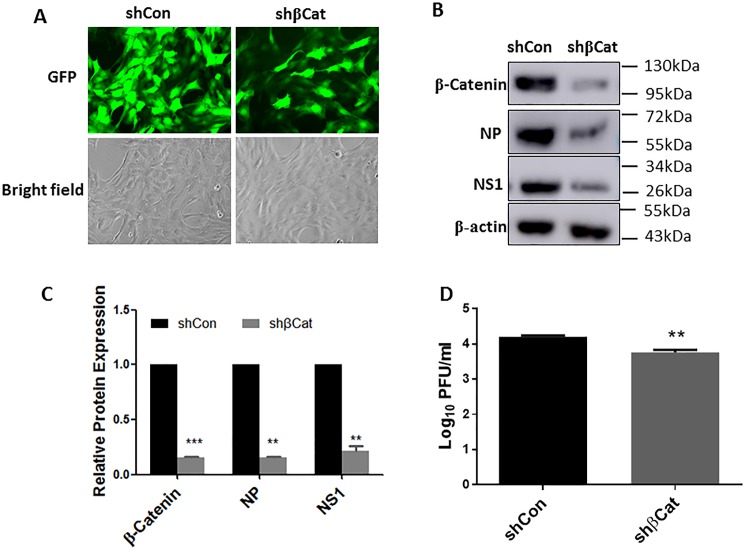
Knockdown of β-catenin reduced viral replication.Rat lung epihtelail L2 cells were treated with adenoviral shRNA targeting β-catenin (shβCat) or a control vector (shCon) at an MOI of 100 for 48 h and then infected with A/PR/8/34 (MOI 0.01) for 48 h. (A) GFP signal after 48 h adenoviral infection. (B) Representaive western blots of β-catenin and viral proteins, NS1 and NP. (C) Quantiation of wesetern blots. (D) Virus titer as determined by plaque assay. **p<0.01 vs. shCon, ***p<0.001 vs. shCon, n = 3 (Student’s t-test).